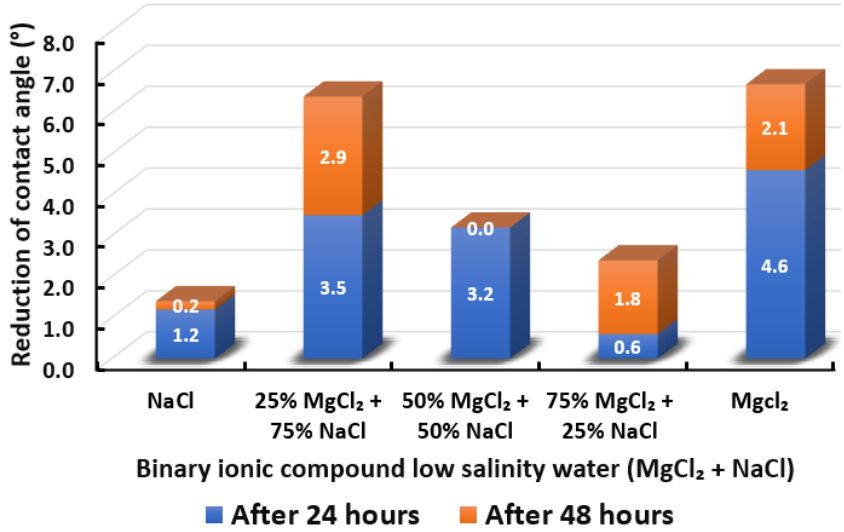
Figure 16. Contact angle reduction results for binary ionic compounds smart water (SW) solutions MgCl 2 + NaCl (3500 ppm).